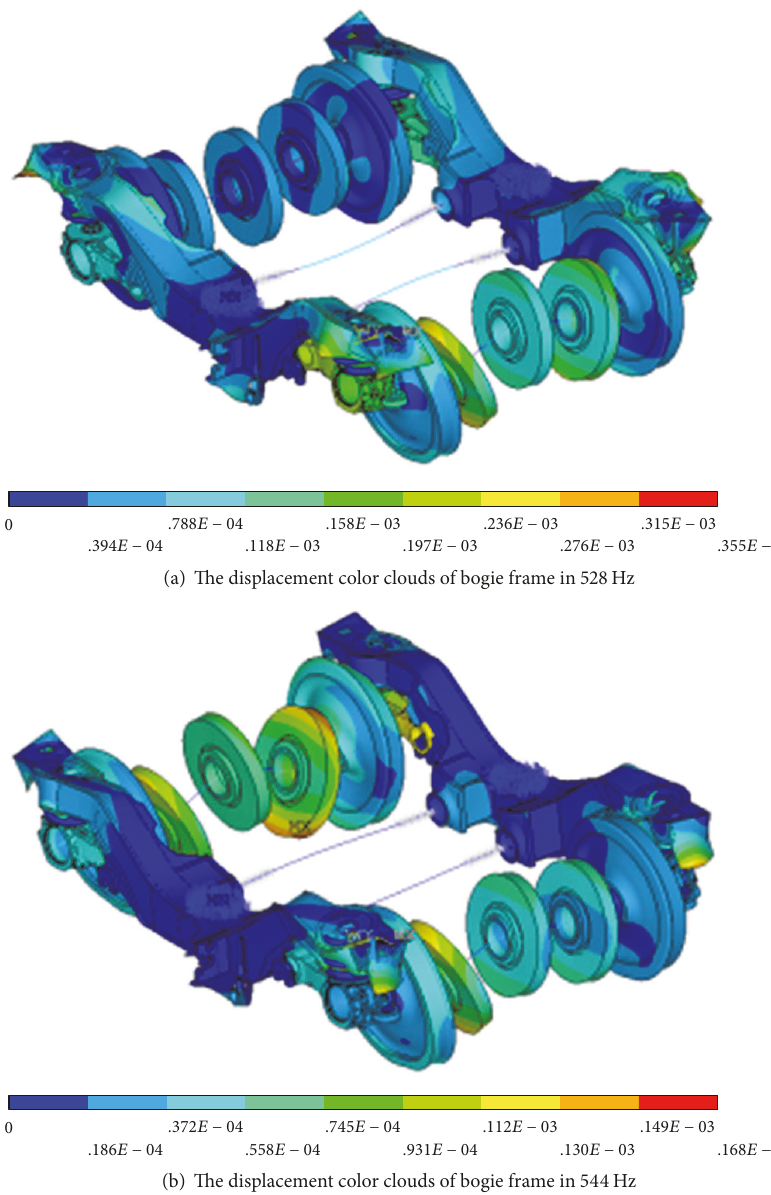
Figure 12: Displacement color clouds of bogie frame in 520 ∼ 560 Hz.